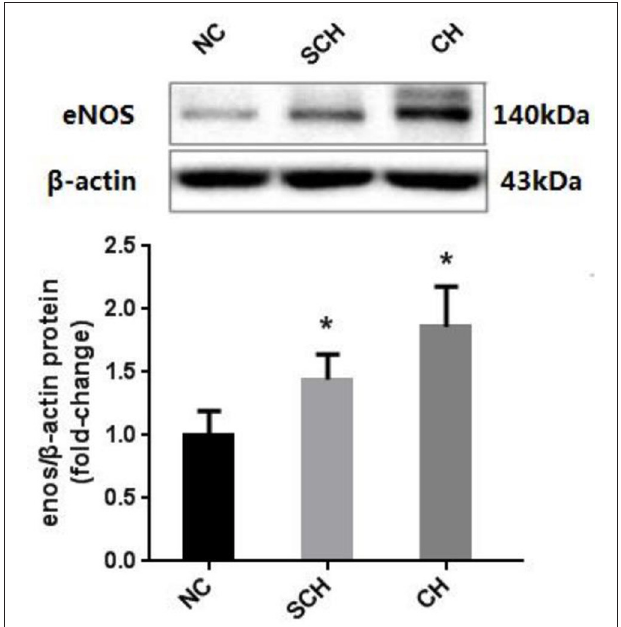
FIGURE 2 | Protein expression of PGRN in aortic tissue in different groups. NC, normal control; SCH, subclinical hypothyroidism; CH, clinical hypothyroidism; N = 10 in each group. * P < 0.05, when compared with the NC